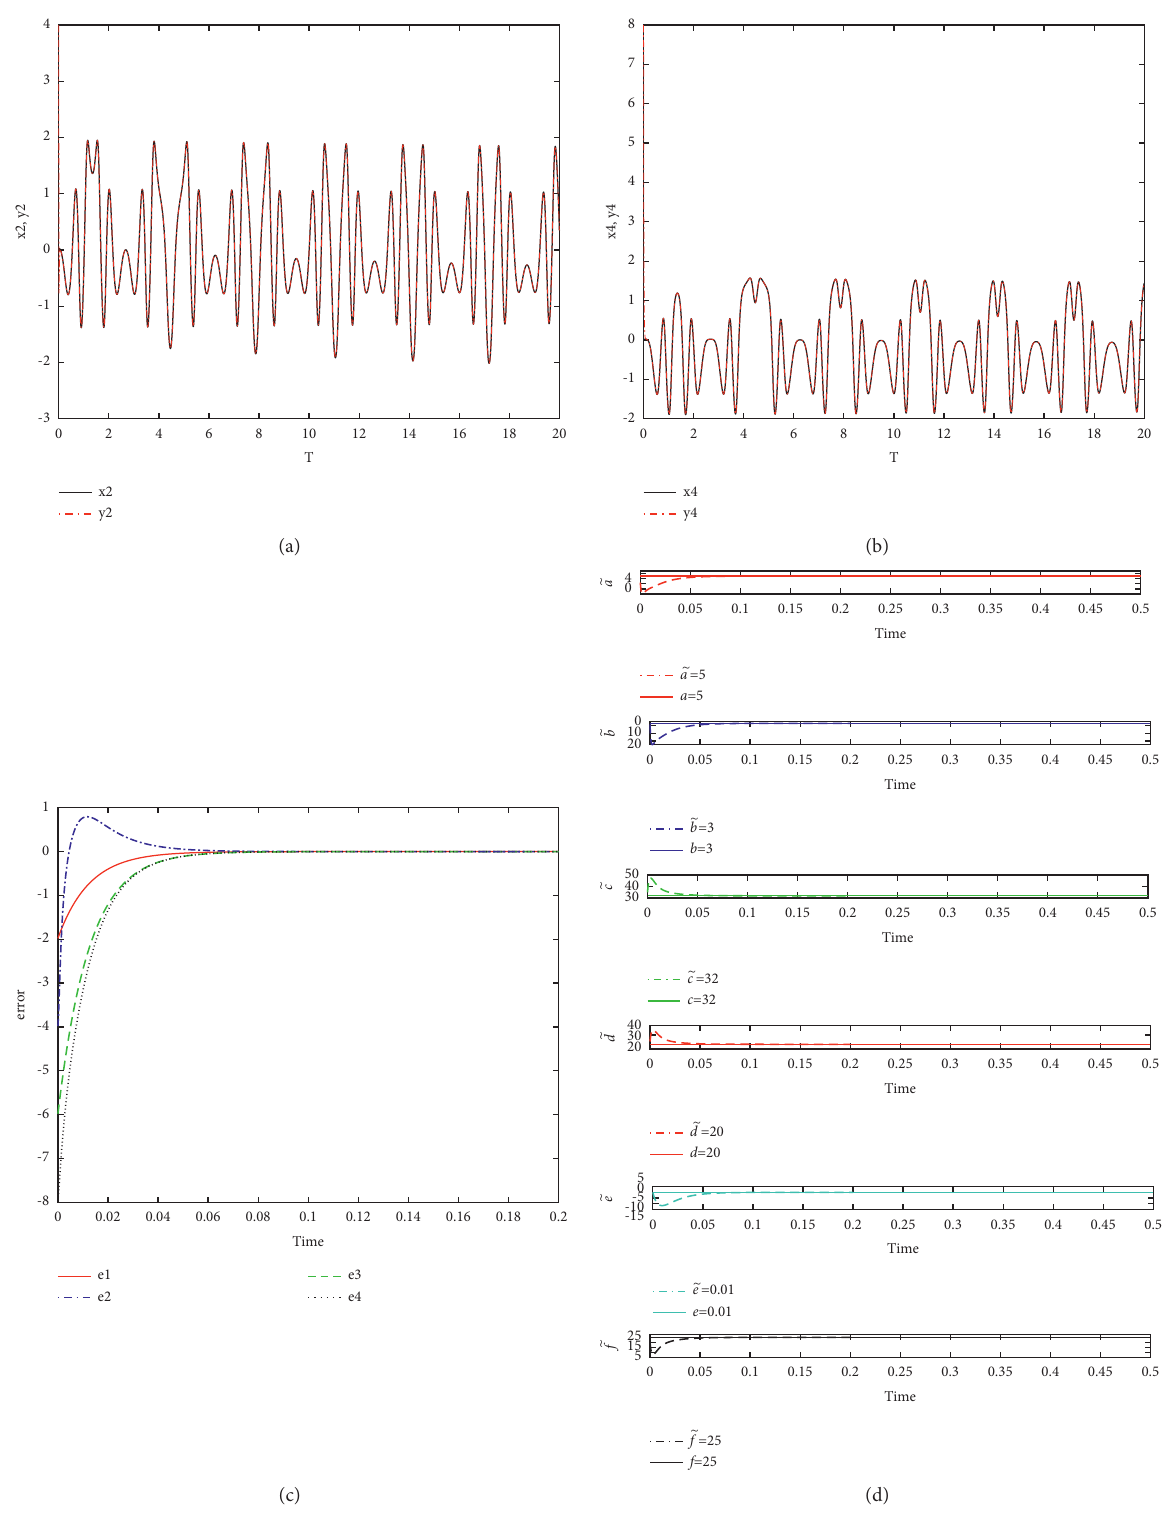
Figure 12: Synchronous simulation. (a) Synchronization waveform of x (c) Synchronization errors e